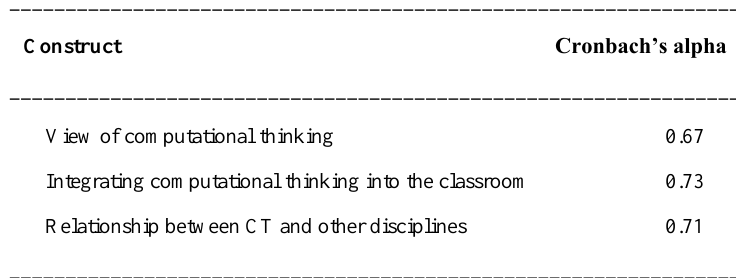
Table 3: Cronbach’s alpha values for the constructs investigated